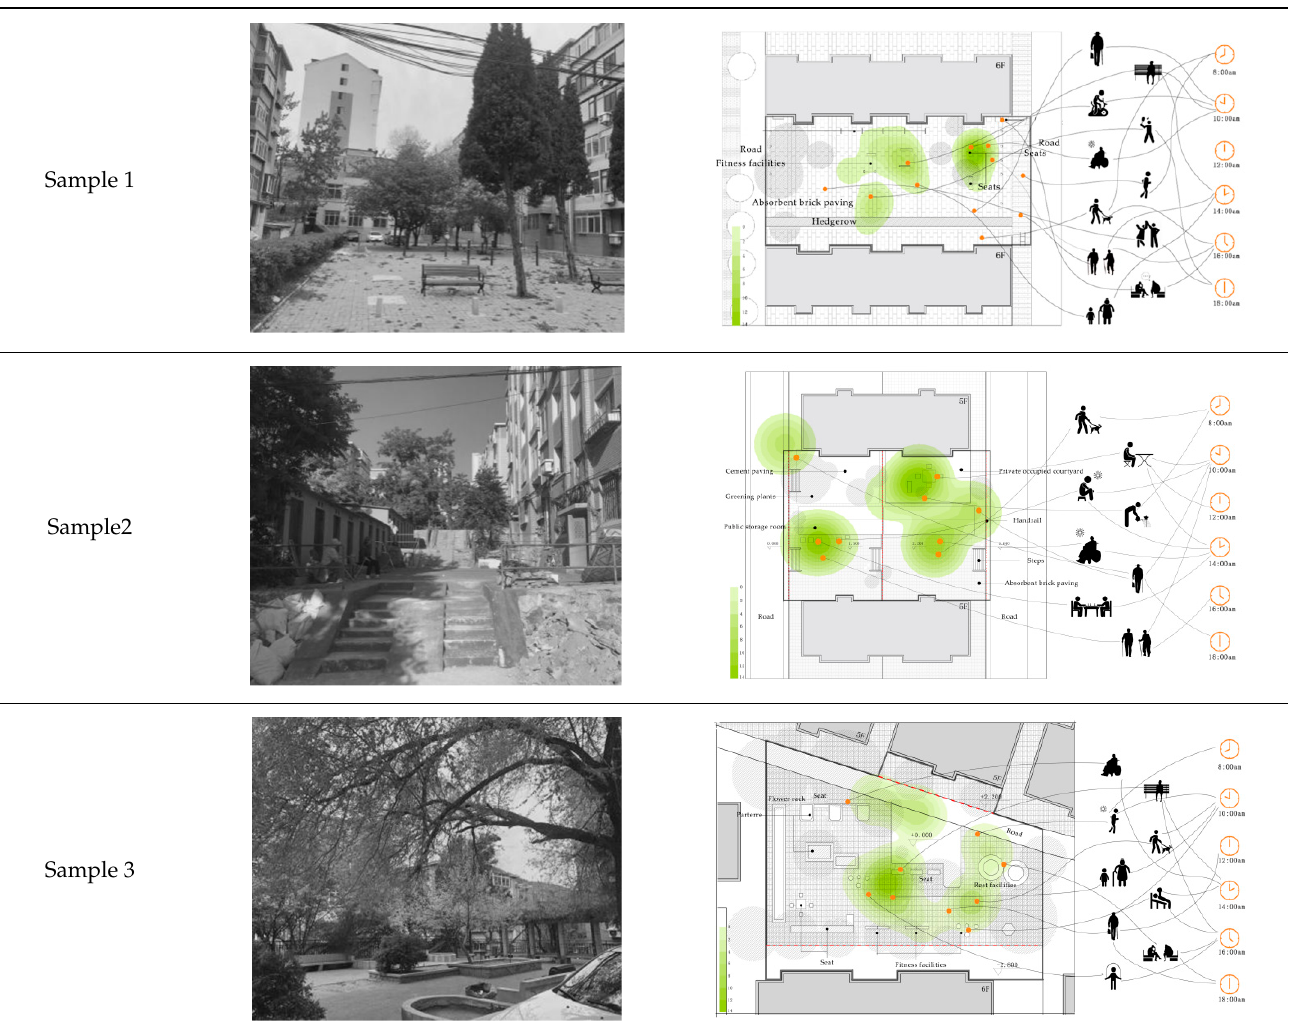
Table 2. Characteristics of residential activities of the elderly on sunny days (overlapping two-day data 8:00–18:00).